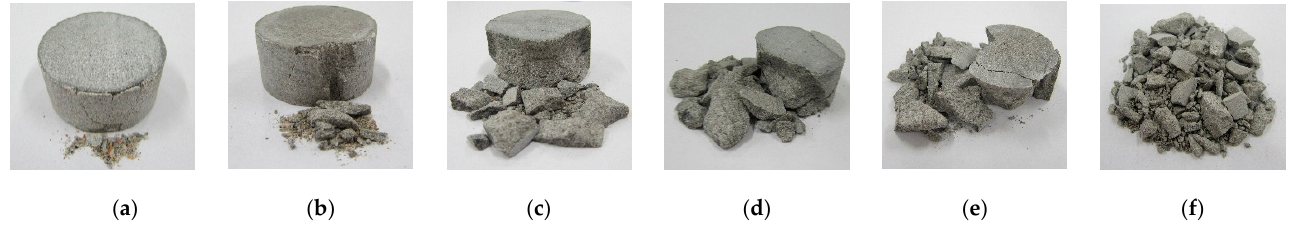
Figure 10. Impact compression failure forms of sandstone with different corrosion times. Non-corroded ( a ), corroded 1 d ( b ), corroded 3 d ( c ), corroded 7 d ( d ), corroded 14 d ( e ), and corroded 28 d ( f ).